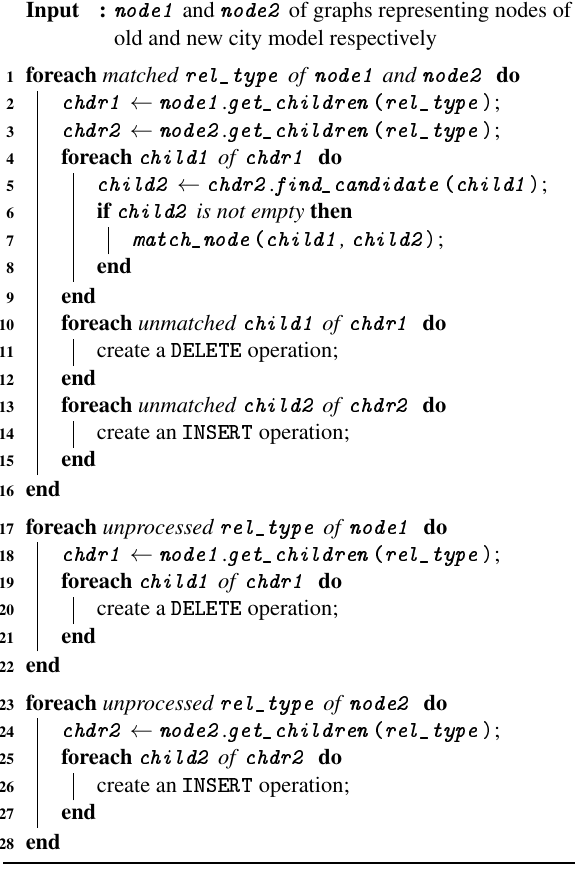
Algorithm 2: match_relationships(node1,